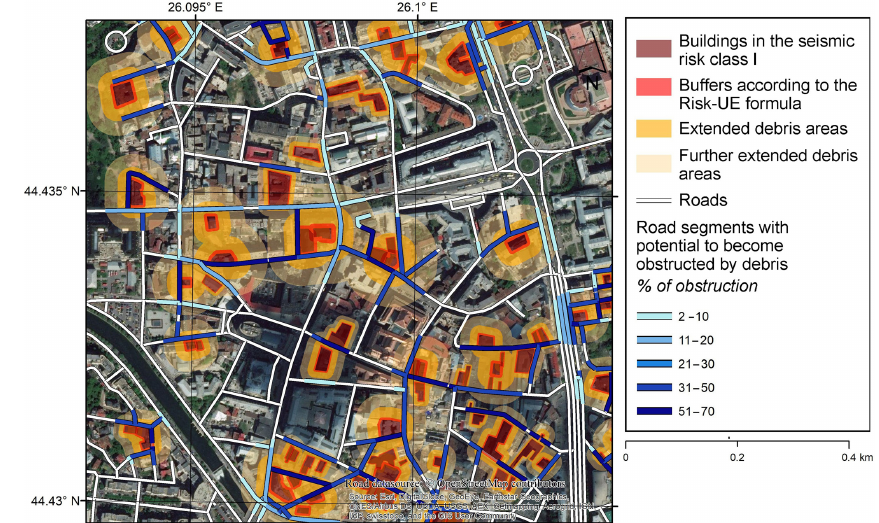
Figure 4. Example of road blockage analysis due to building debris, applied for the historical center of Bucharest. (Datasource: © Open- StreetMap contributors 2019. Distributed under a Creative Commons BY-SA License; data from September 2016. Basemap: © ESRI and contributors.) Table 1. Factors considered for determining the probability of road segments to be affected by earthquakes. Factor Method of analysis